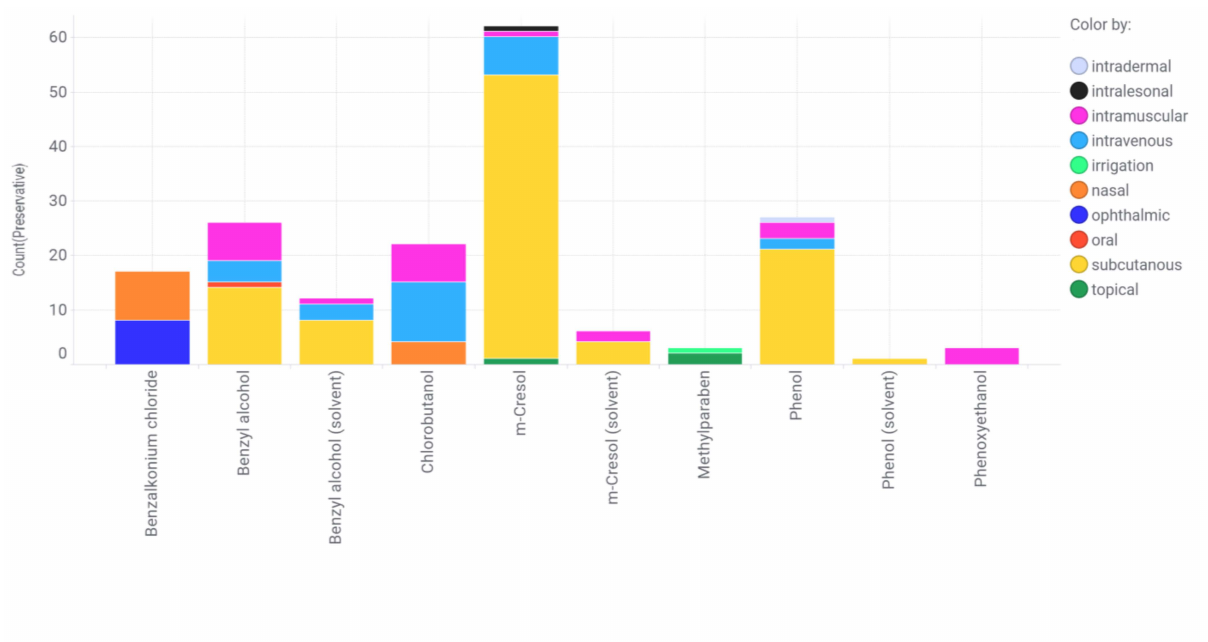
Figure 2. Preservative distribution in dependence on the route of administration. The values are given as the number of correlations found in market products (protein and peptides). Combinations of preservatives and hits from antibacterial water were not taken into account. Table 12 lists the concentrations of preservatives used in market products containing proteins or peptides as API depending on the application route. Table 12. Concentration ranges of preservatives in mg/mL depending on the application route.